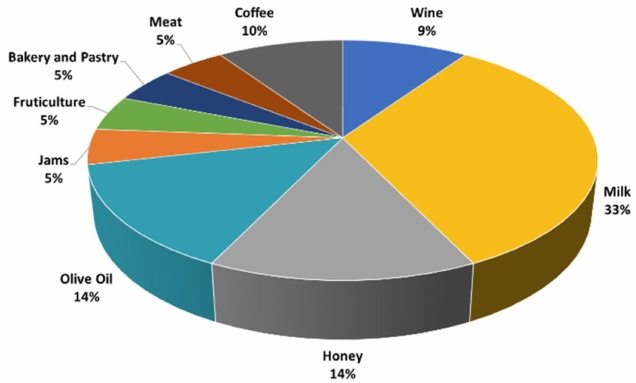
Figure 2. Distribution of surveyed companies by sector of activity.